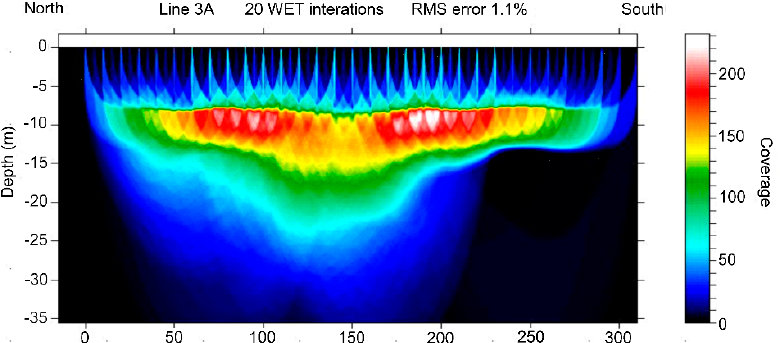
Figure 5. Coverage profile based on number of front and reverse wave crossovers. The red and yellow zones occur in areas were the most shots and wave path crossovers occurred.